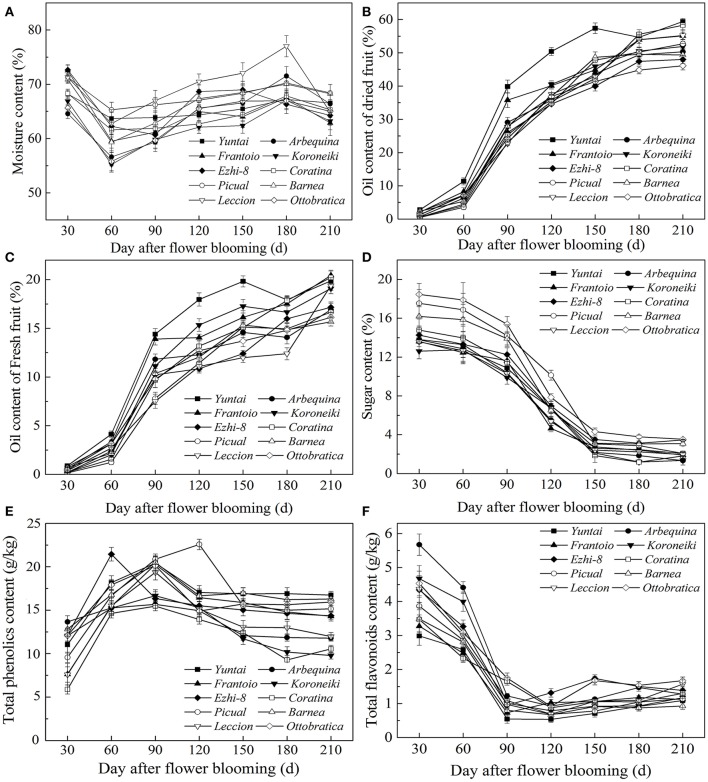
Variation of qualitative characteristics during fruit development. (A) Moisture content (B) Dried fruit oil content (C) Fresh fruit oil content (D) Sugar content (E) Total phenolics content (F) Total flavonoids content.